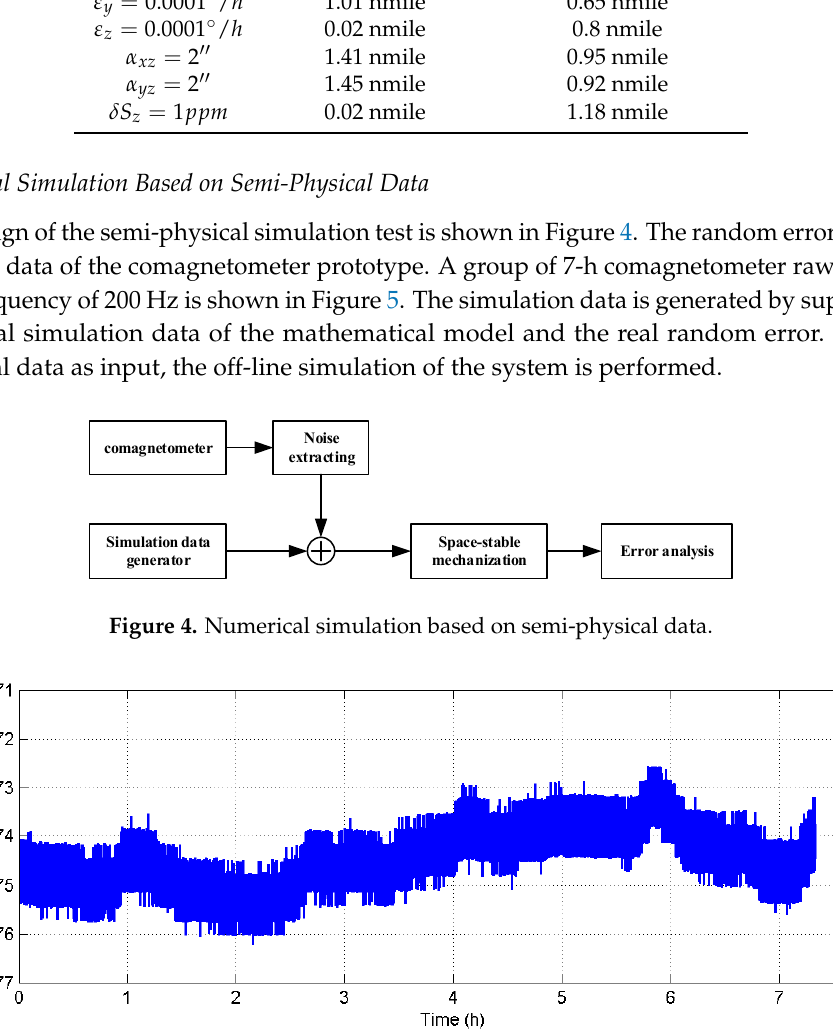
Figure 5. Raw data of the comagnetometer.